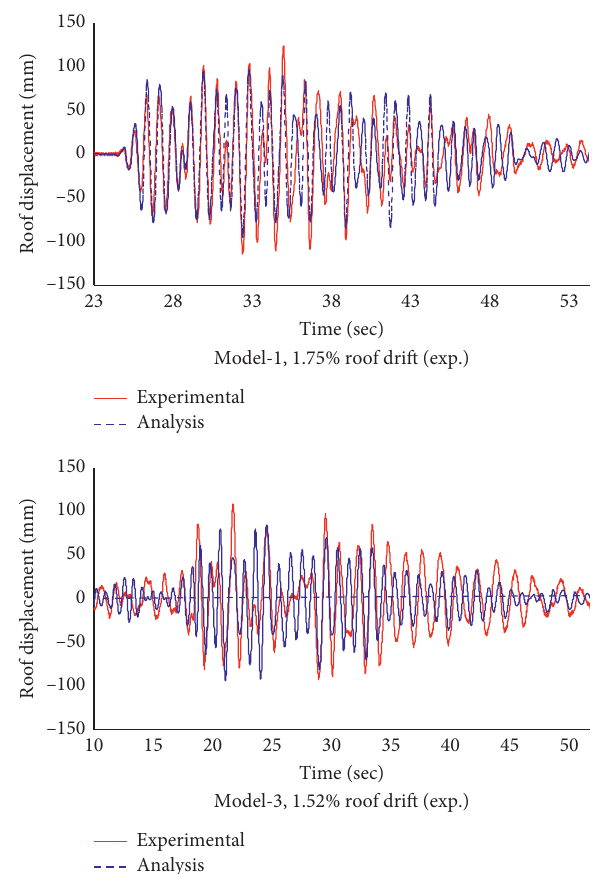
Figure 14: Roof displacement time history response of tested RC frames. Figure 14 is reproduced from Ahmad et al. [13].